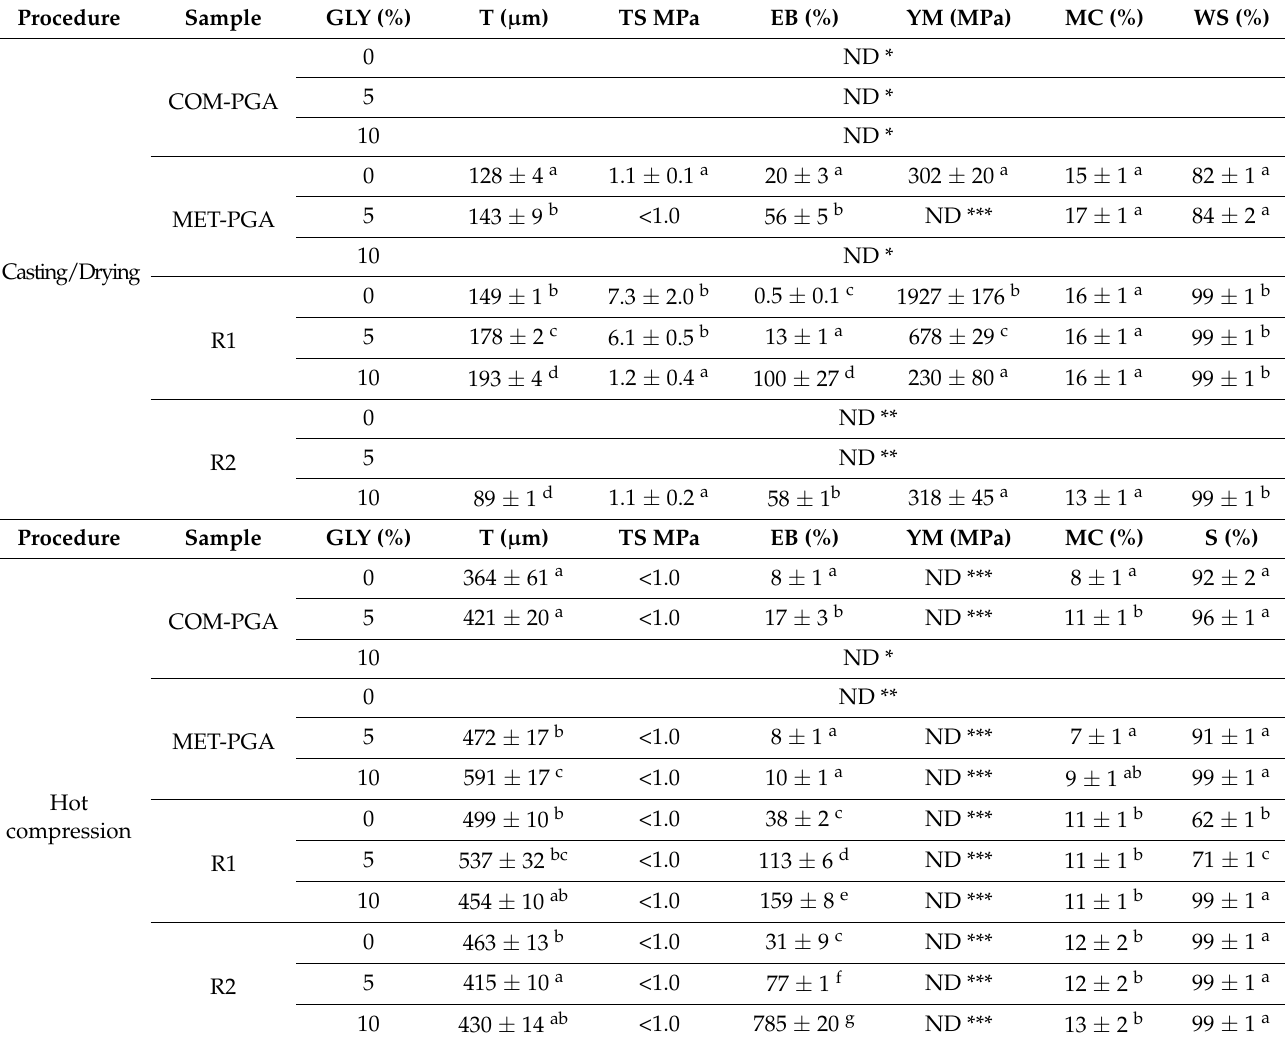
Table 2. Mechanical and hydrophilicity properties of the films obtained by either casting or hot compression of the different γ -PGA samples (ND, not detectable values because of the unmani- pulable (either * sticky or ** brittle) material obtained or because of *** the very low tensile strength (TS) values (<1.0 MPa) detected. Different small letters (a–g) indicate significant differences among the values reported in each column for each procedure ( p < 0.05). Further experimental details are given in the